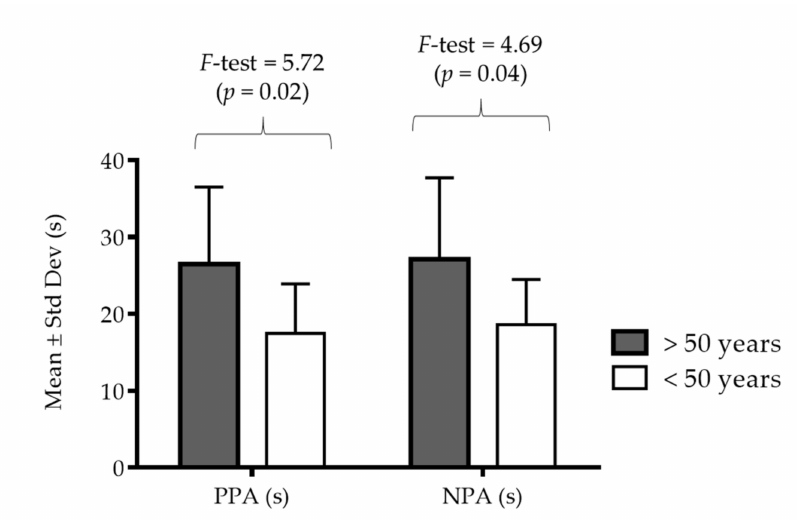
Figure 2. Descriptive statistics for tests of non-planned agility (NPA), and pre-planned agility (PPA) with differences between age